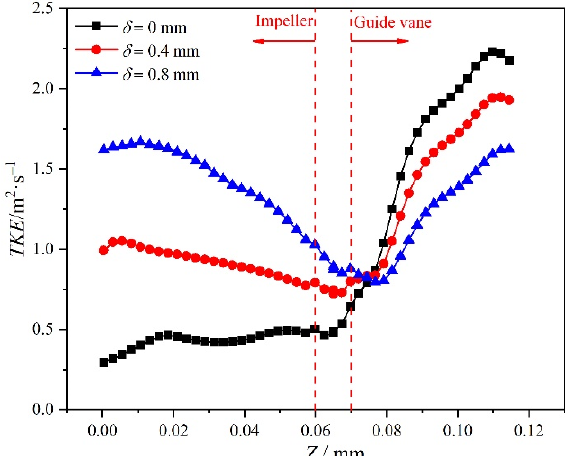
Figure 9. Average turbulence kinetic energy from the impeller inlet to the guide vane outlet.